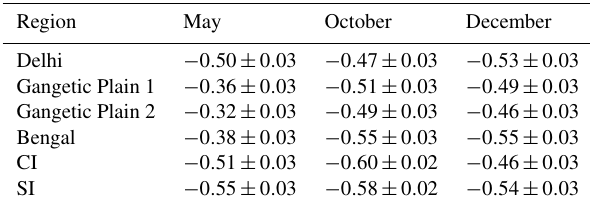
Figure 4. Monthly-mean 3-hourly averaged values of (cid:49) BC (%). The IST hours for each plot have been written in the bottom-right corner. The (cid:49) BC values are plotted for May 2011 as a representa- tive. Table 2. The correlation coefficient between | (cid:49) BC | and the sim- ulated PBL height in the CTRL configuration for the six chosen 1 ◦ × 1 ◦ grid